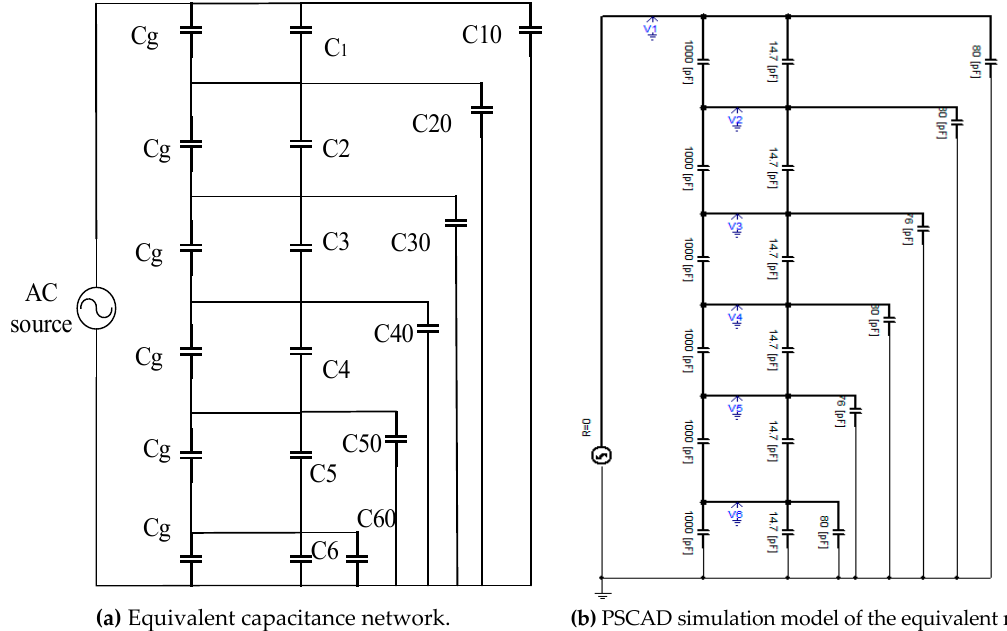
Figure 6. The equivalent circuit model of the 363 kV VCB with a grading capacitor.